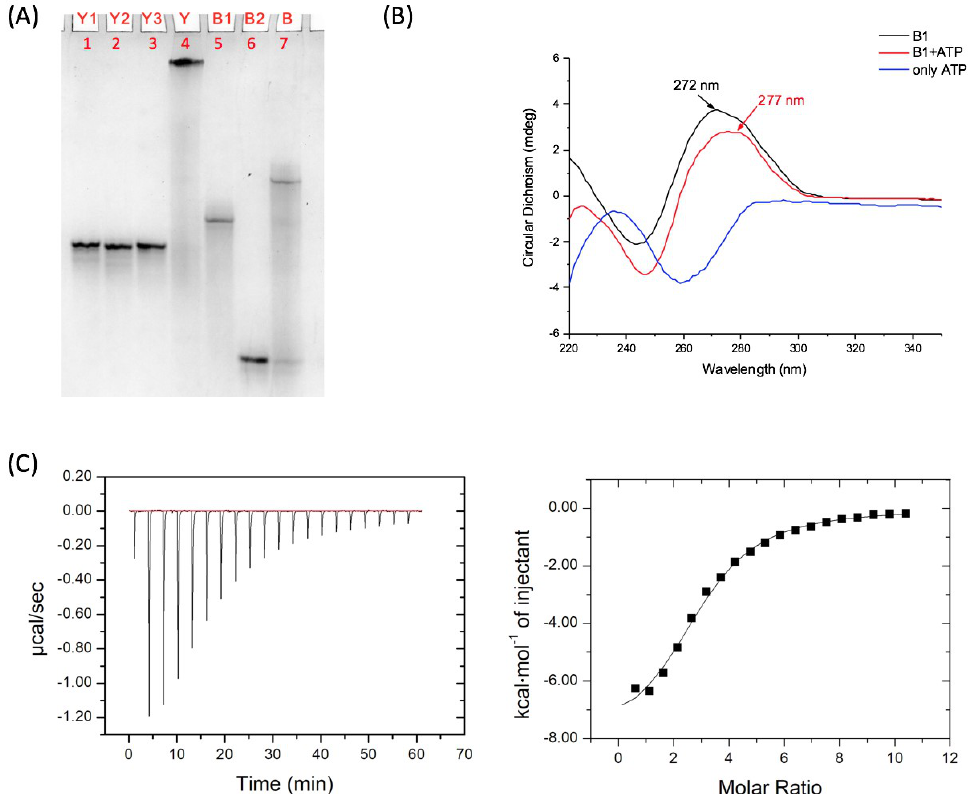
Figure 1. Characterization of the DNA assemblies and ATP aptamer structure. ( A ) Characterization of Y-scaffold and B-linker by 20% native PAGE. Three ssDNAs Y1 ( Lane 1 ), Y2 ( Lane 2 ), and Y3 ( Lane 3 ) hybridized to form the Y-scaffold ( Lane 4 ), and two ssDNAs B1 ( Lane 5 ) and B2 ( Lane 6 ) assembled into the linear B-linker ( Lane 7 ); ( B ) CD spectra to characterize the conformation of the aptamer sequence in DNA strand B1 with or without ATP; and ( C ) Isothermal titration calorimetry (ITC) data ( left ) and fitting curve ( right ) of binding strength between B1 and